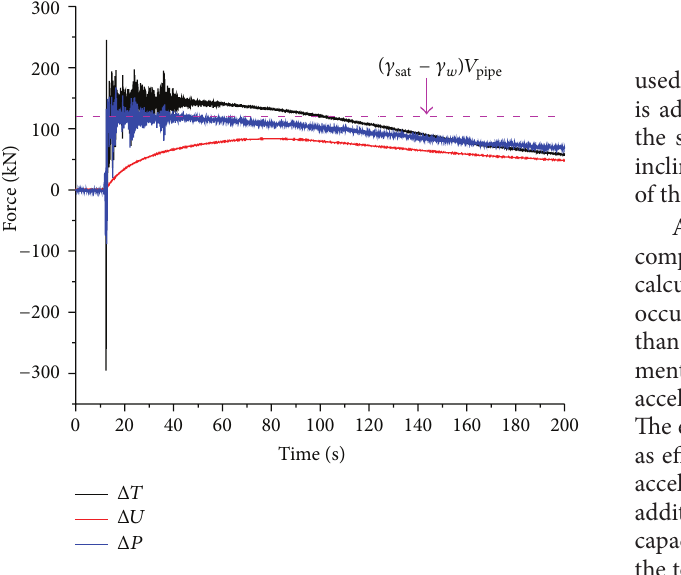
Figure 14: Relationship among Δ𝑇,Δ𝑃 and Δ𝑈 under 0.5 g El- Centro wave in test 1.